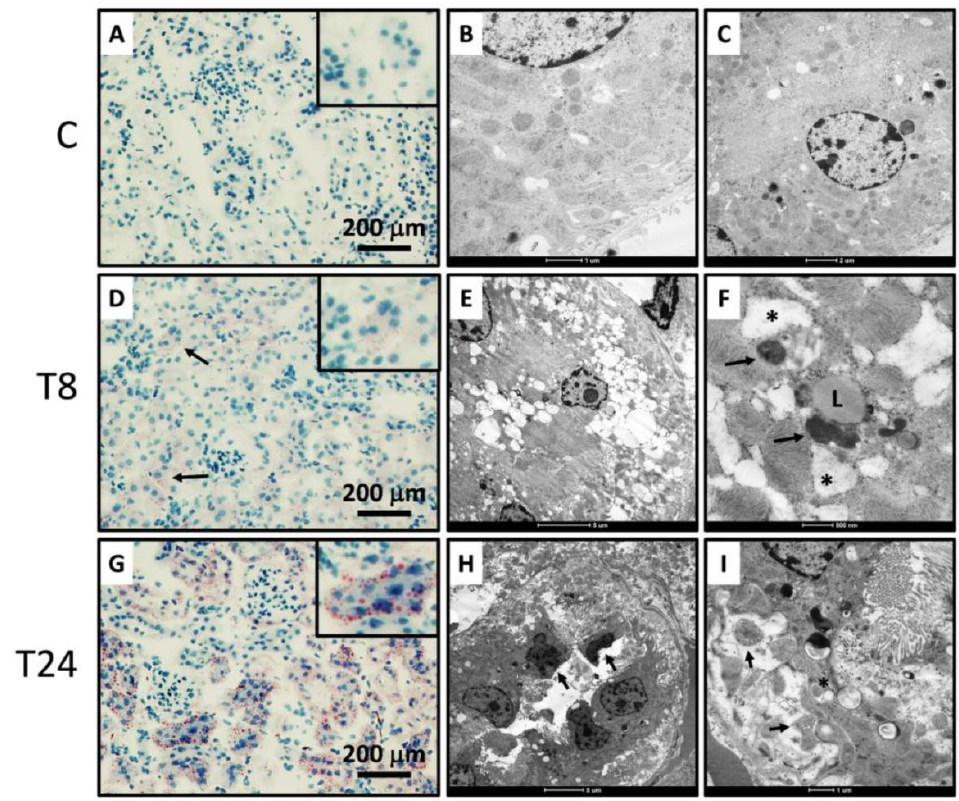
Figure 2. Altered kidney morphology induced by tunicamycin administration. ( A ) Frozen kidney sections of control mice stained with Oil Red O. ( B ) Low-power electron microscopy of kidneys from control mice. ( C ) High-power electron microscopy of kidneys from control mice. ( D ) Frozen kidney sections stained with Oil Red O 8 h after tunicamycin administration. Some convoluted tubules show red stained droplets in the cytoplasm (arrows) that correspond to lipid vacuoles. Inset shows high-power field tubule with some lipid droplets. ( E ) Low-power electron microscopy shows numerous cytoplasmic vacuoles in epithelial cells from convoluted tubules 8 h after tunicamycin administration. ( F ) High-power electron micrograph of proximal convoluted epithelial cell 8 h after tunicamycin administration. The distended rough endoplasmic reticulum (asterisks) is surrounded by mitochondria, lysosomes and lipid droplets (L). ( G ) Frozen section stained with Oil Red 24 h after tunicamycin administration. There are numerous epithelial cells from proximal convoluted tubules with red labeled lipid droplets. Inset shows high-power field tubule with numerous lipid vacuoles. ( H ) Low-power electron microscopy micrograph from proximal convoluted tubule 24 h after tunicamycin administration. There are necrotic cells (arrow) intercalated with damaged epithelial cells with basal cytoplasmic dissolution (asterisks). ( I ) High-power micrograph from the same area shown in H. There is cytoplasmic dissolution with some mitochondria with a slightly expanded matrix (arrows) and lysosomes associated with vesicles conforming to autophagosomes (asterisk).